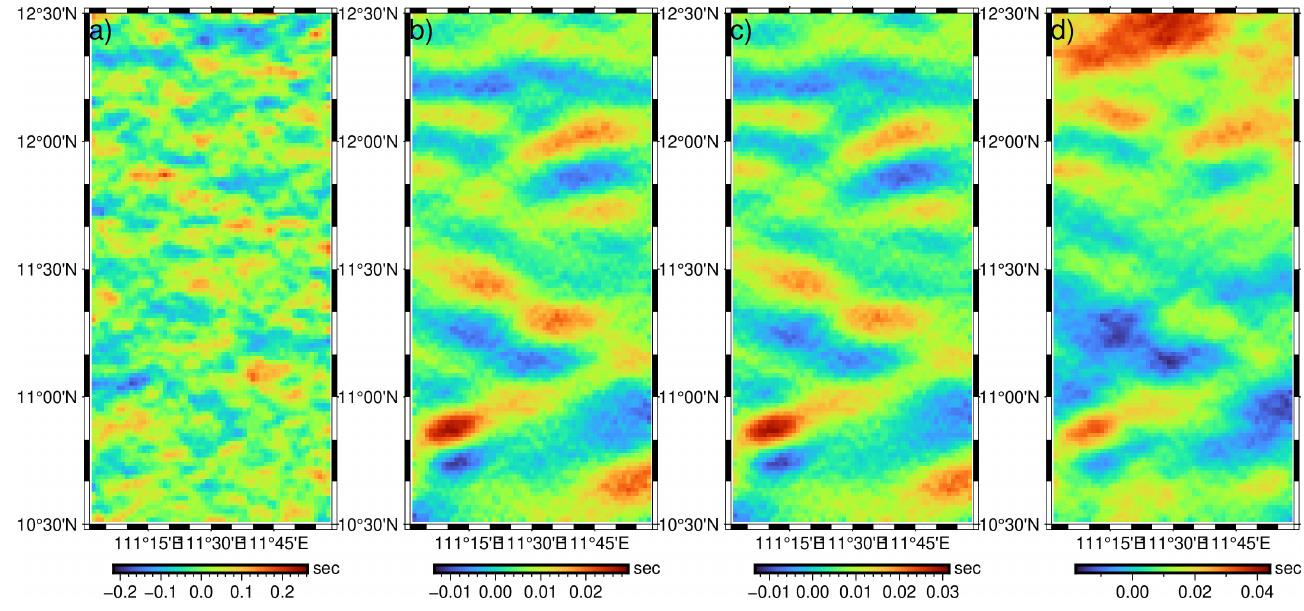
Figure 10. Error of north-south component of DV caused by: ( a ) wet troposphere; ( b ) dry troposphere; ( c ) ionosphere; ( d ) SSB.